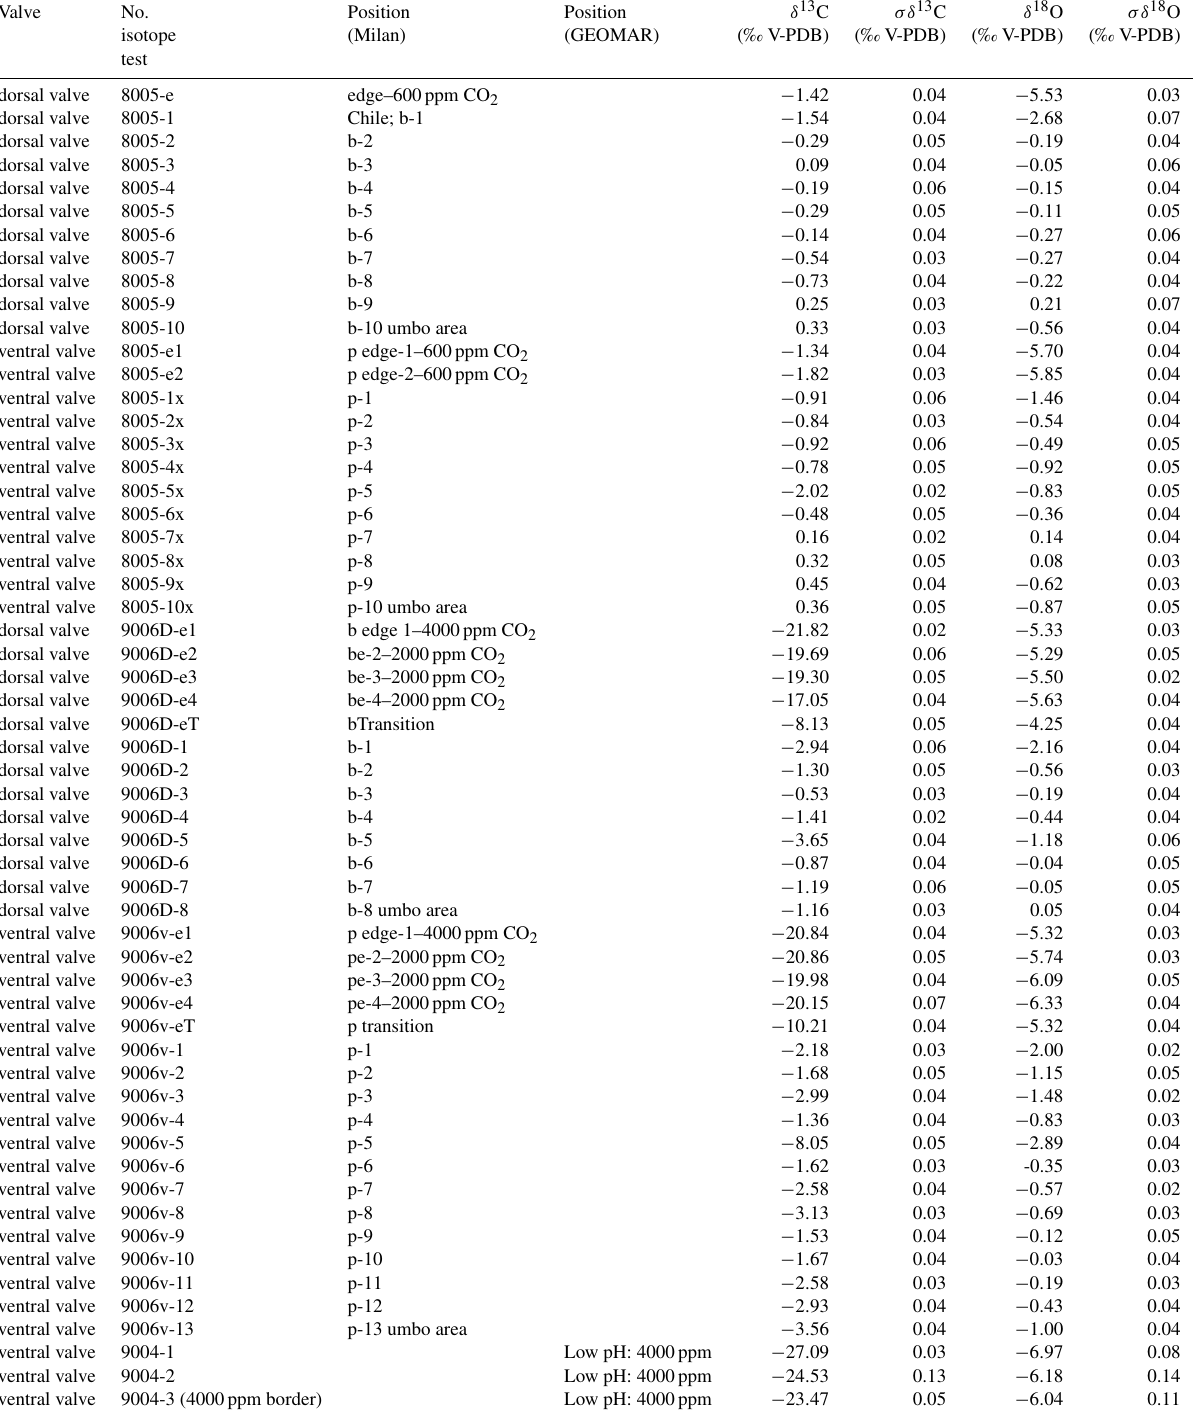
Table A1. Carbon and oxygen isotope compositions of cultured brachiopod shell sampled in the secondary layer, along the growth increments from margin to umbo (shown in the paper Fig.